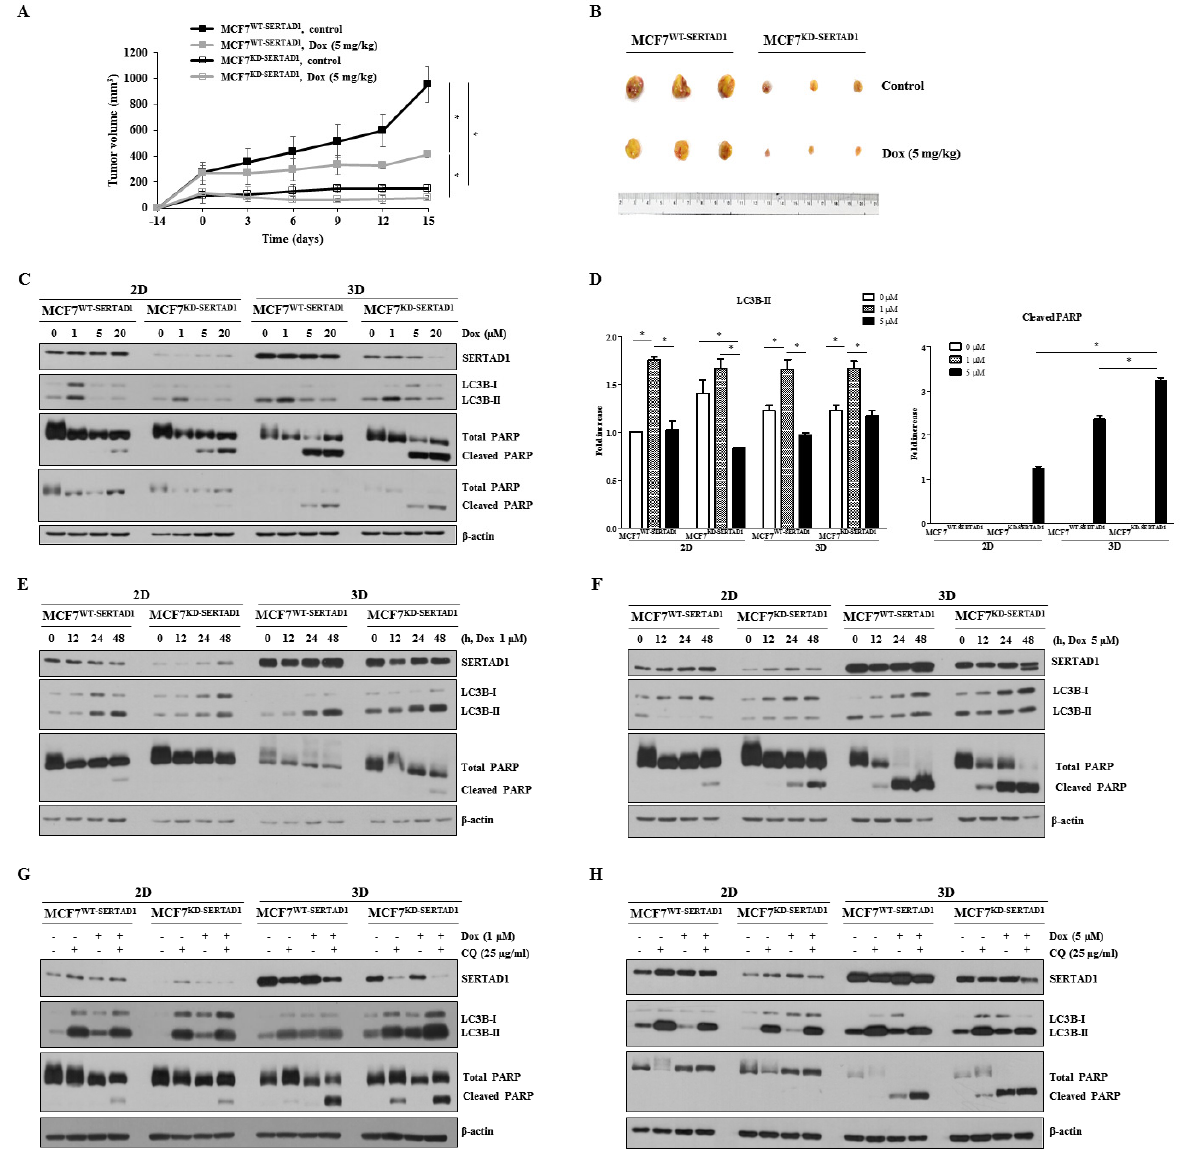
Figure 3. SERTAD1 to promote sensitivity of MCF7 to Dox. ( A , B ) Changes in tumor size upon Dox treatment. Data are presented as mean ± SD based on six tumor-bearing animals. Representative tumors (n = 3). ( C – F ) Western blot analysis of autophagic and apoptotic markers (LC3B and PARP, respectively) in the two stable cell lines in the presence or absence of treatments in 2D and 3D culture. ( G , H ) Single treatment or co-treatment of the autophagy inhibitor and Dox in the presence or absence of SERTAD1. Cells are cultured for 24 h before being subjected to treatments, including either Dox 1 μ M or 5 μ M or CQ (25 μ g/mL). Protein expression of SERTAD1, LC3B-I, LC3B-II, total and cleaved PARP are examined and normalized to β -actin. Data are representative of at least three independent experiments with similar patterns. Blotting results were quantified using ImageJ. * p < 0.05.